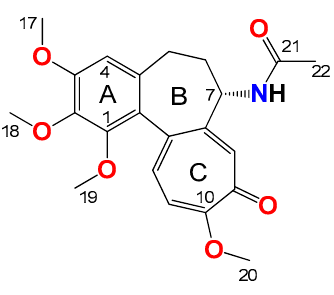
Figure 1. Structure of colchicine ( 1 ).